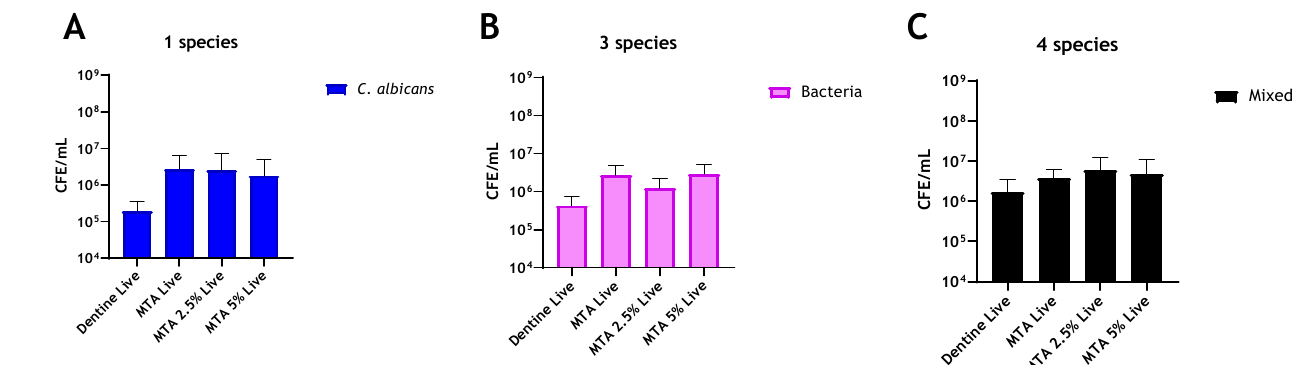
Figure 3. Compositional analysis of biofilms on MTA material discs. Live/dead qPCR was conducted following incorpo- ration of 2.5 wt% and 5 wt% of chitosan: ( A ) Live CFE/mL of C. albicans- only biofilms, ( B ) Live CFE/mL of bacterial-only biofilms and ( C ) Live CFE/mL of 4-mixed biofilms (biofilms containing C. albicans ). The bacterial and fungal loads were quantified using 16S and 18S primers, respectively. Bovine dentine and unaltered MTA discs were used as controls. Data were analysed by Kruskal–Wallis with Dunn’s tests.